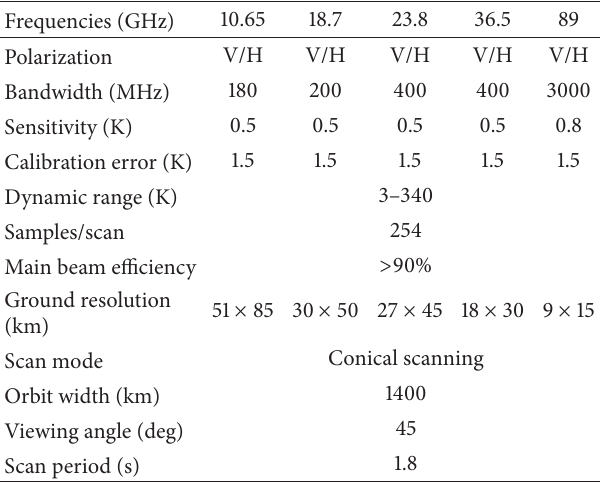
Table 1: Performance requirements for the FY-3B MWRI